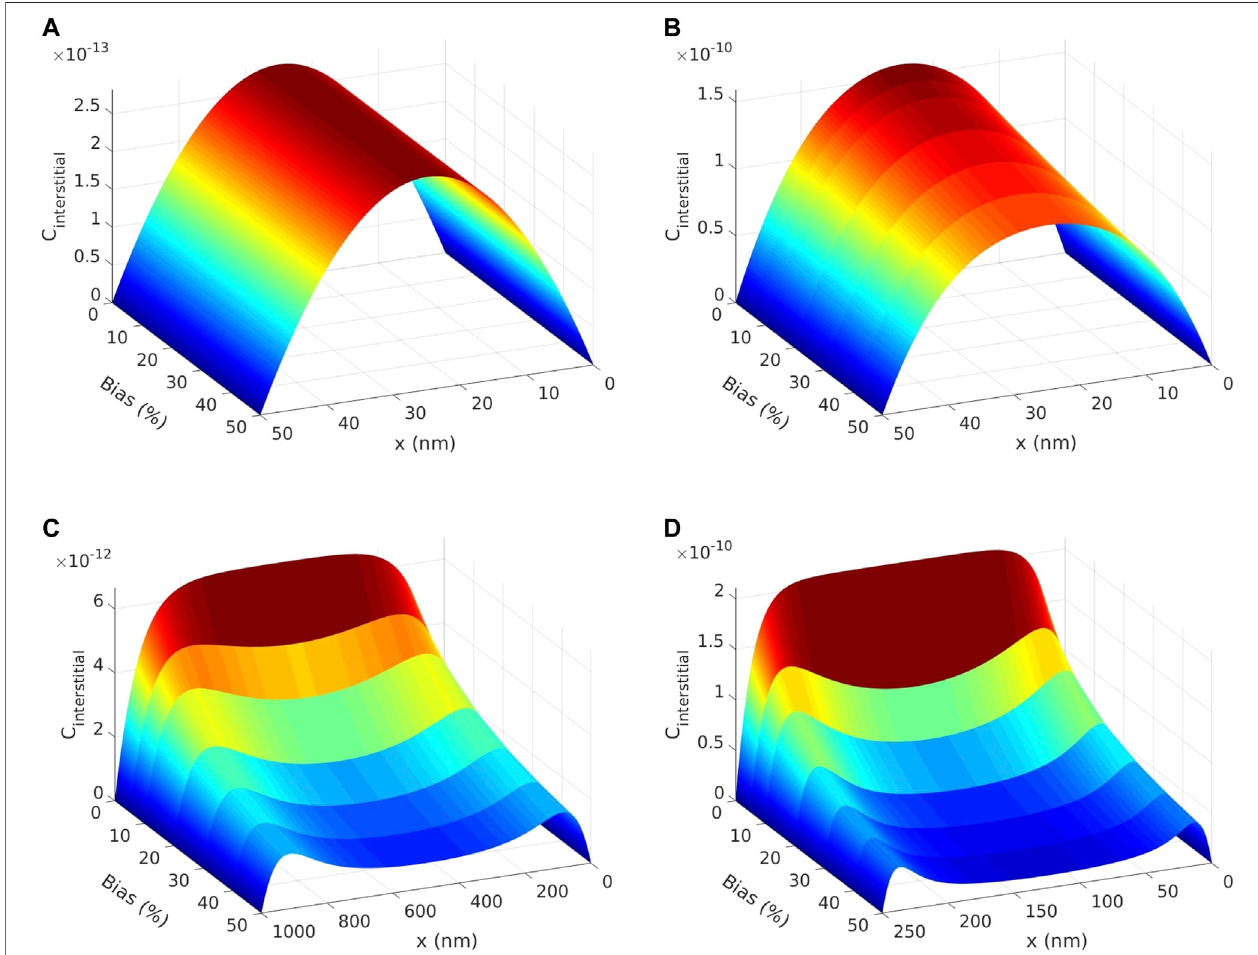
FIGURE 6 | An illustration of the combined effects of size, dose rate, and production bias on the steady-state pro fi les of interstitials. Change of interstitial concentration pro fi les with production bias for (A) low dose rate (1e-6 dpa/s) at 50 nm grain, (B) high dose rate (1e-3 dpa/s) at 50 nm grain, (C) low dose rate (1e-6 dpa/s) at the critical grain size ( ≈ 1,000 nm), (D) high dose rate (1e-3 dpa/s) at the critical grain size ( ≈ 250 nm).